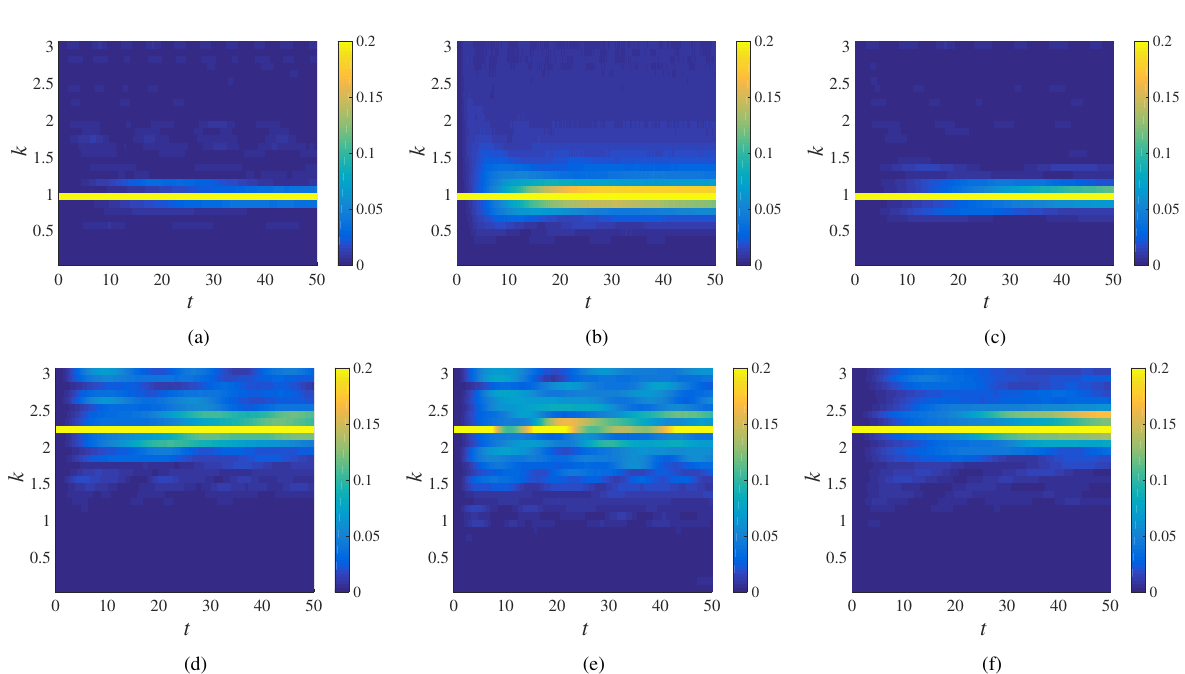
Figure 2. Binned total energy response ( (cid:104) ˆ e ( t ) (cid:105) ) of chains made with ratio ν = 0 . 1 (a,d), 0.5 (b,e), and 0.9 (c,f) agitated initially with k ins = 0 . 981 (top row) and k ins = 2 . 159 (bottom